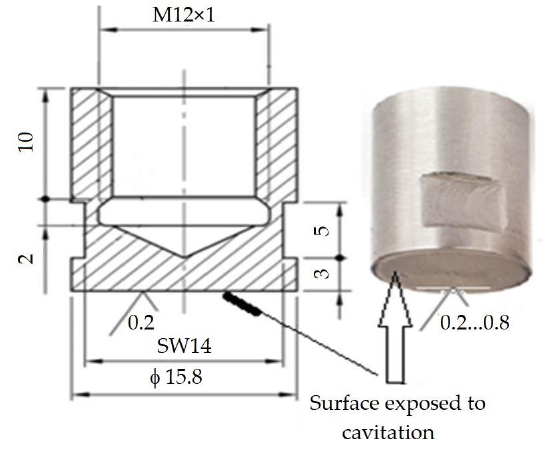
Figure 4. Geometry of the cavitation samples (mm).